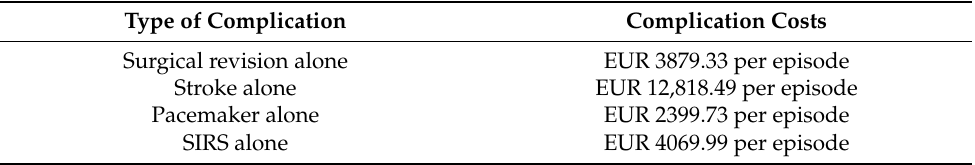
Table 5. Hospital costs per episode of serious clinical